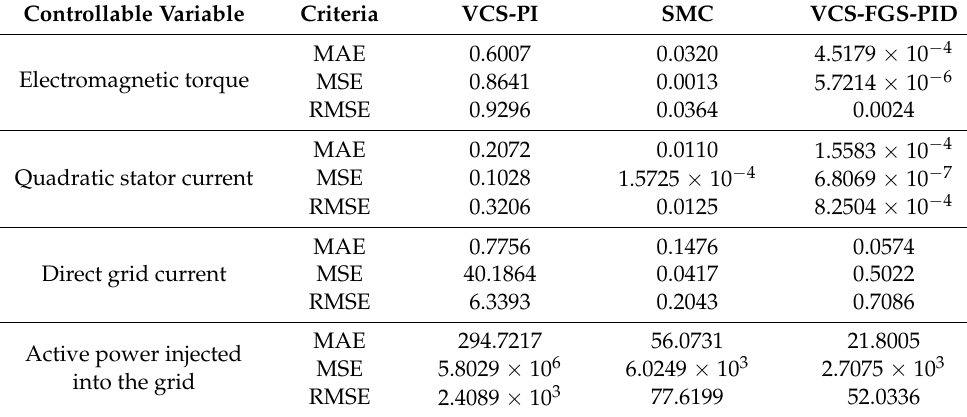
Table 7. Comparison between studied controllers.